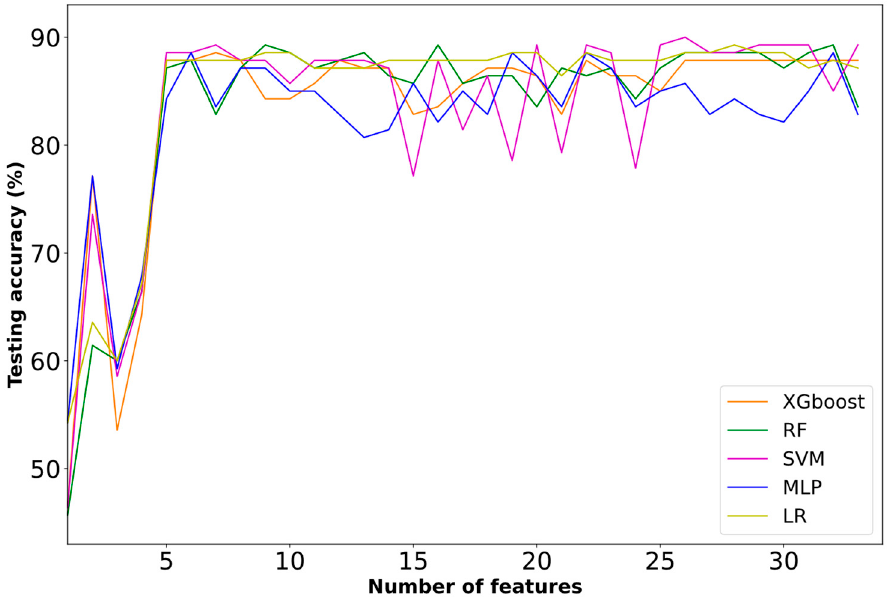
Figure 4. Learning curves based on the testing performance of second approach.